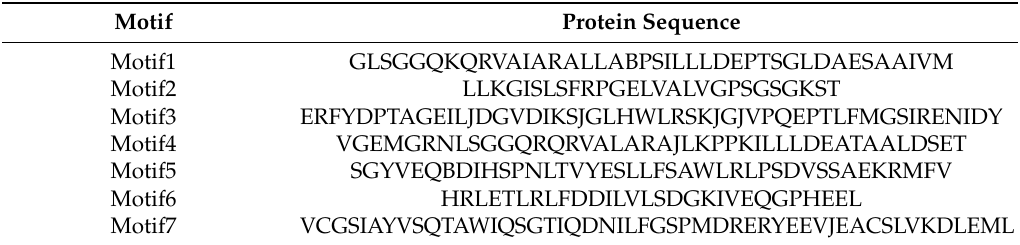
Figure 3. Conserve amino acid in seven motifs of ABC gene family in barley. Motif analysis and the sequence logos was performed using MEME website. Table 2. Seven conservative motif protein sequences given by the MEME online